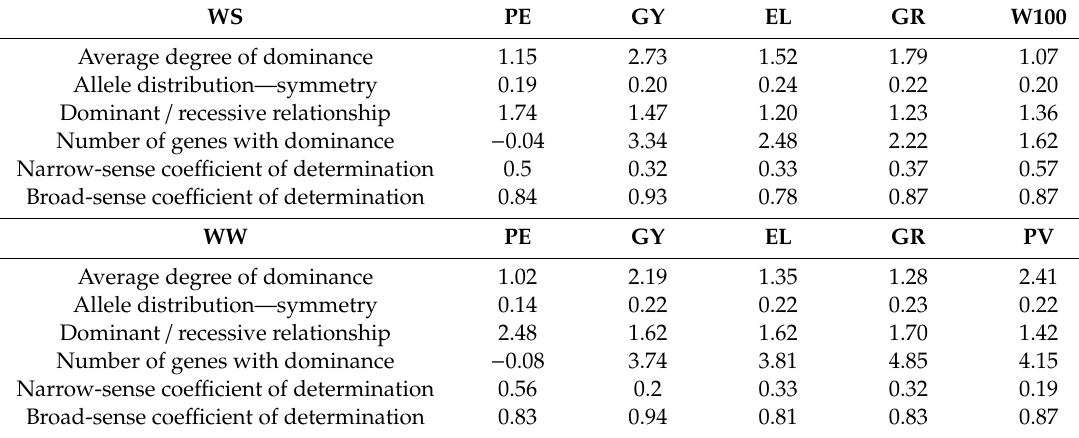
Table 4. Estimates of genetic and non-genetic parameters, according to Hayman’s diallel analysis (1954) of thetraits evaluatedin popcorn genotypesunder water-stress (WS)and well-watered (WW) conditions.